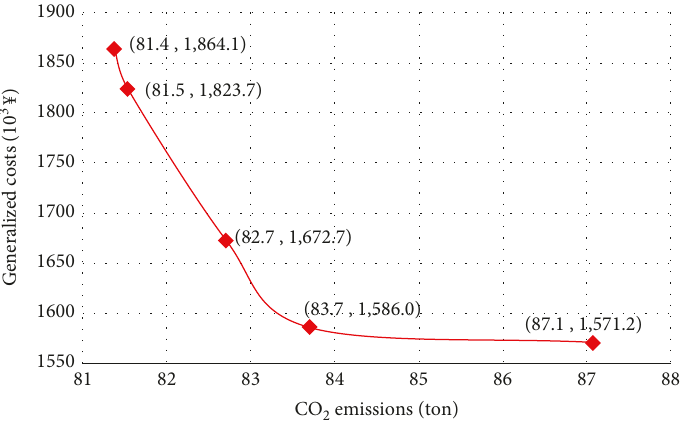
Figure 8: Pareto solutions to the bi-objective optimization problem.